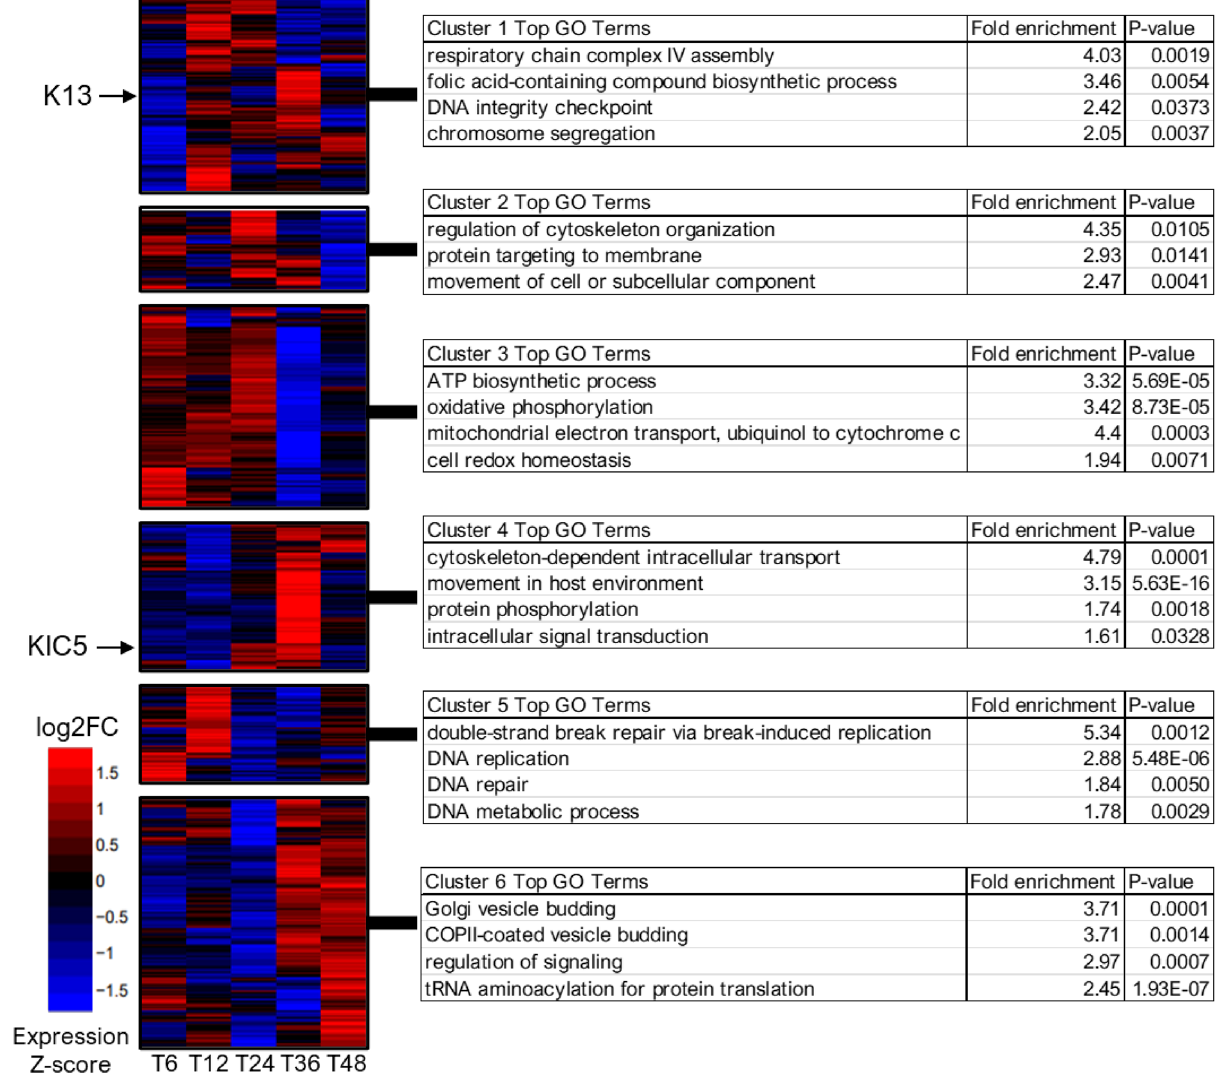
Figure 4. Clustering of dysregulation genes across the KIC5 transcriptome. Cluster heatmap of KIC5 mutant log2-fold change (log2FC) values. Bioinformatic analysis to determine optimal clustering identified 6 gene clusters with similar differential expression patterns in the KIC5 mutant clone compared to the isogenic wild- type NF54 clone (Supplementary Fig. 7, Supplementary Table S11). The location of protein KIC5 and K13 in the heatmap are indicated with arrows. Heatmap displayed as Expression Z-score of log2-fold change (KIC5 mutant/NF54) values. Top GO biological processes of each cluster are shown in the corresponding tables, analyzed via PlasmoDB gene ontology enrichment tool (Supplementary Table S12). Significant p-value <